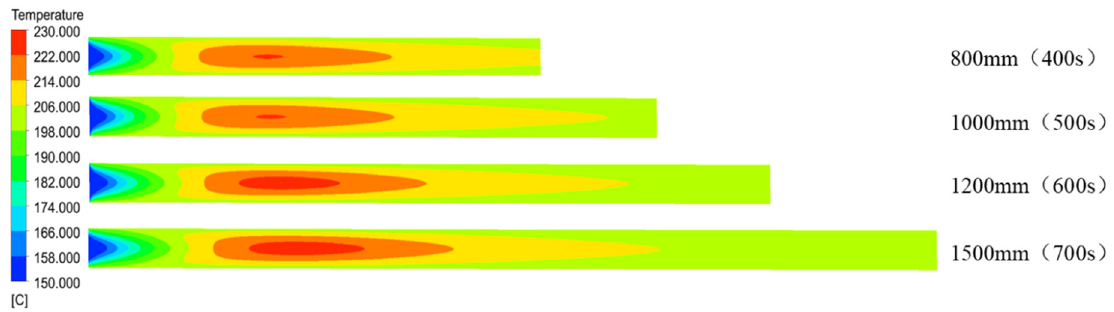
Figure 22. Cloud diagram of temperature distribution in the axial section of the microreactor at different tube lengths.